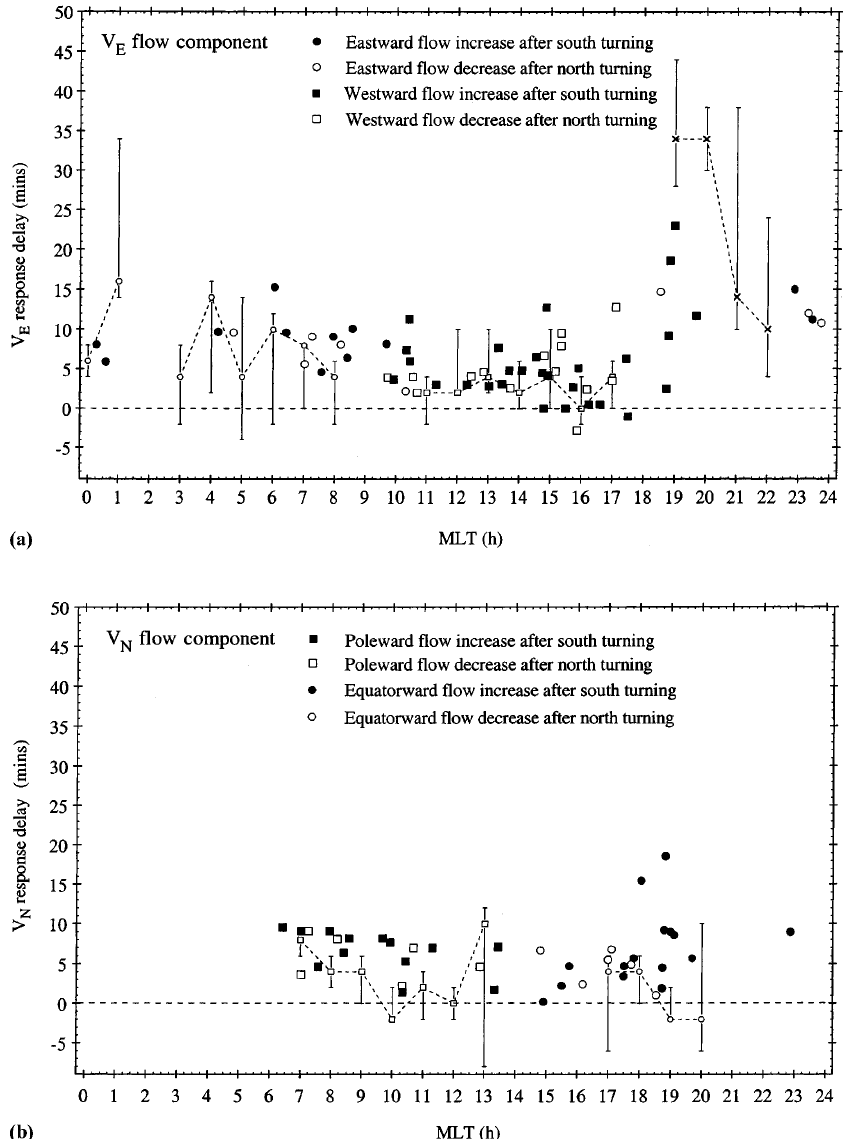
Fig. 7. b As for a , except for the north- south flow component. The square symbols indicate poleward flow, while the circular symbols indicate equatorward flow (as in